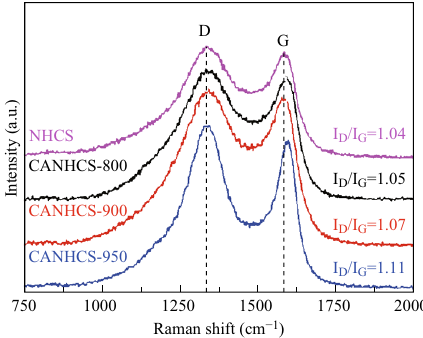
Fig. 7 Raman spectra of NHCSs, CANHCS-800, CANHCS-900